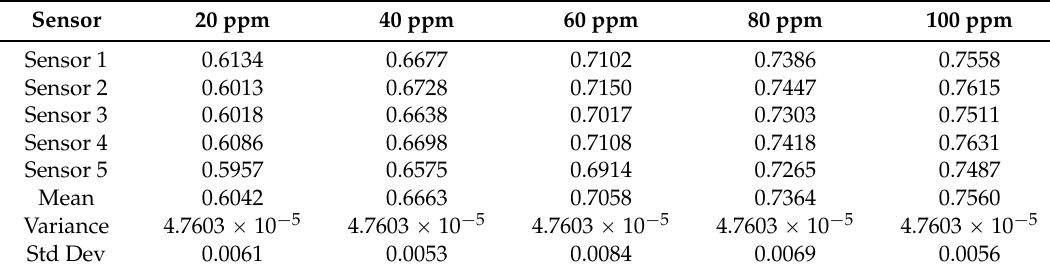
Table 1. Summary of gas sensor calibration results.